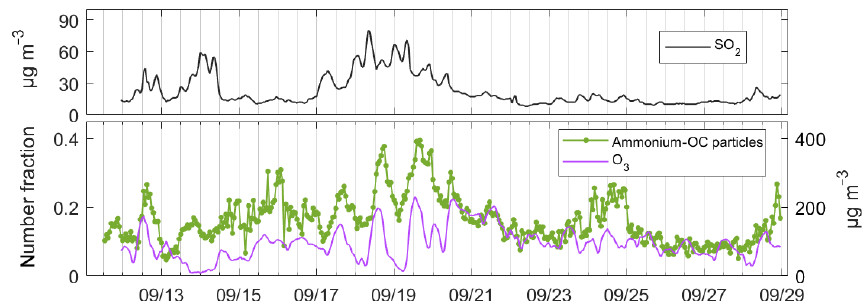
Figure 9. Temporal traces of ammonium–OC relative number concentrations, ambient O 3 and SO 2 concentrations from 12 to 28 September 2012.